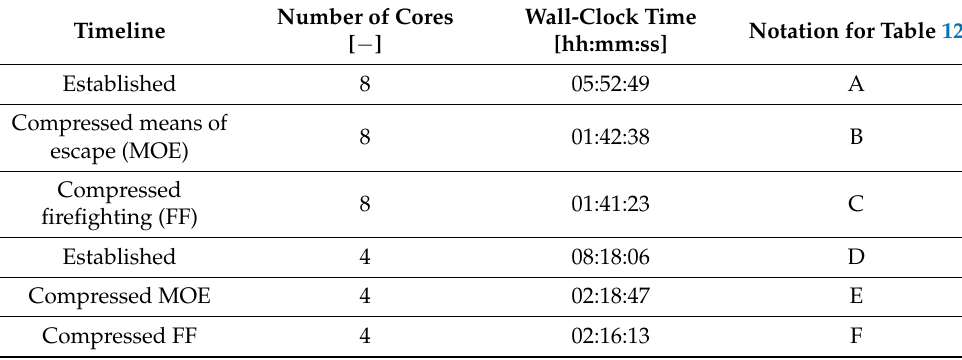
Table 11. Elapsed wall-clock times for each of the timeline approaches for eight and four physical